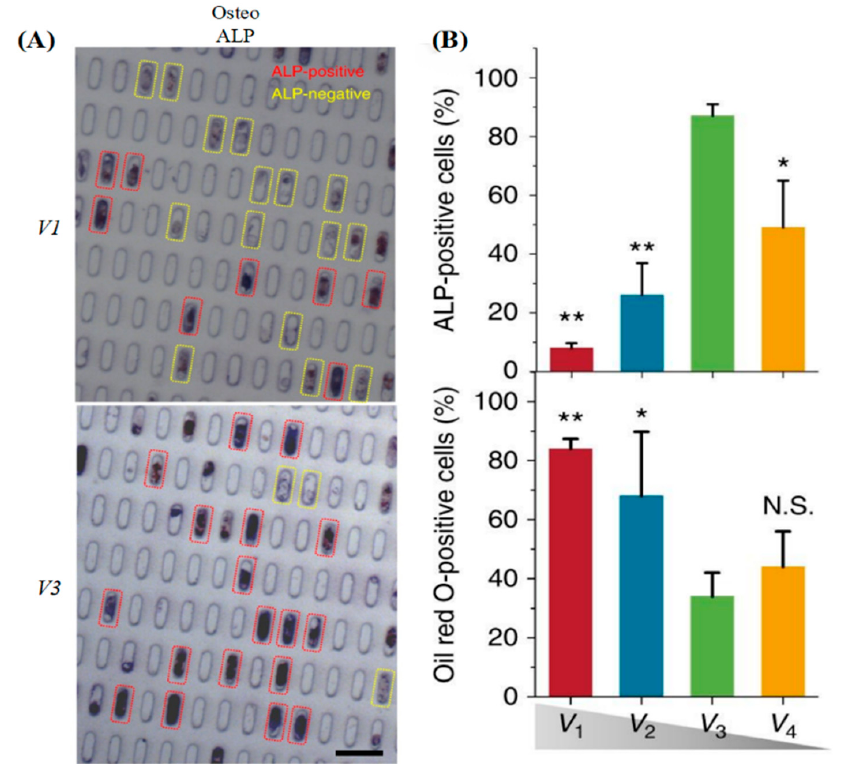
Figure 4. Size affects single hMSC fate. ( A ) Alkaline phosphatase (ALP) staining for cells with dif- ferent V1 and V3 volumes (V1 > V3). The ALP-positive cells were determined by applying an opti- mal threshold to the image; ALP intensity above the threshold was determined as ALP positive. ( B ) Quantification of differentiation after 7 days (ALP) and 10 days (Oil Red O) for cells with different volumes. Mean ± s.d., ANOVA one-way analysis followed by Tukey post-hoc test shows signifi- cance levels of *P < 0.05, **P < 0.01. N.S. no significant difference. Reprinted with permission from